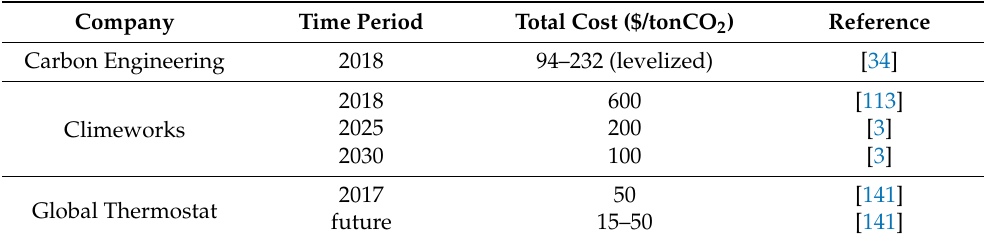
Table 6. Costs of the main DAC